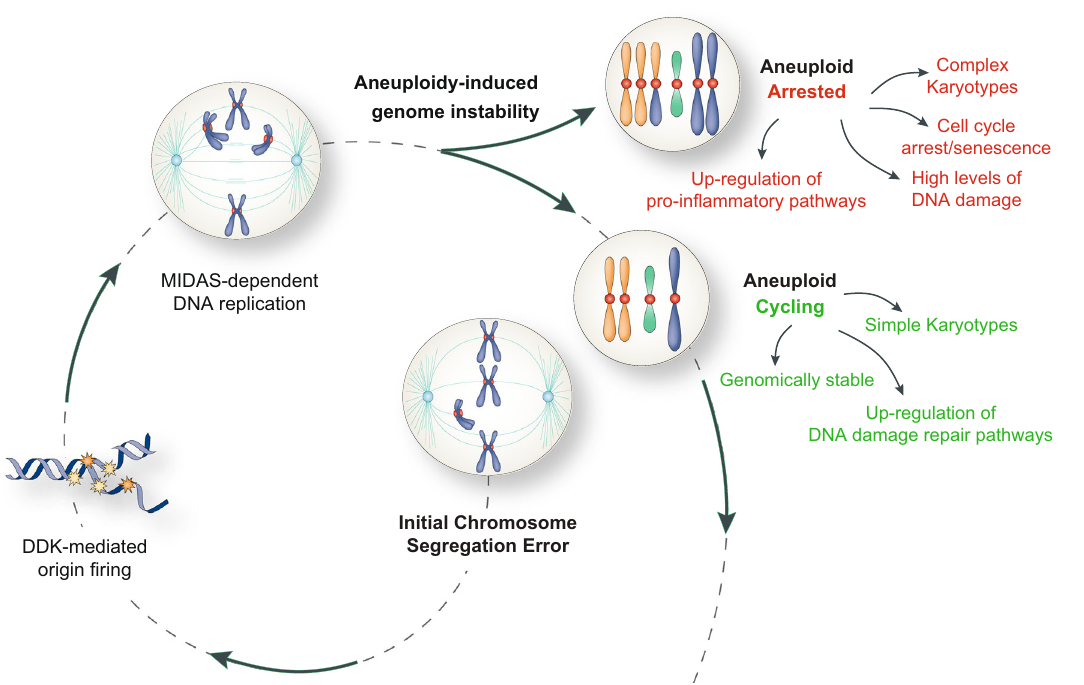
Fig.7|Finalmodel. Amodelforhowaneuploidyinducesgenomeinstabilityanditsconsequences.Seetextformoredetails.Drawingsofschemesweremadebypartially utilizing extracts of fi gures published elsewhere 1